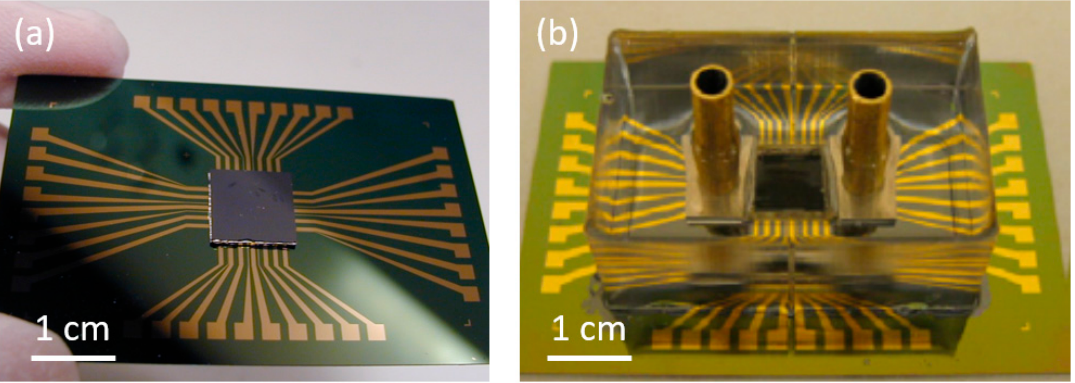
Figure 4. ( a ) On-chip CNT cooling fin test structure mounted on a supporting circuit board. ( b ) Complete cooling system embedded in polydimethylsiloxane (PDMS) with inlet and outlet nozzles for the coolant.